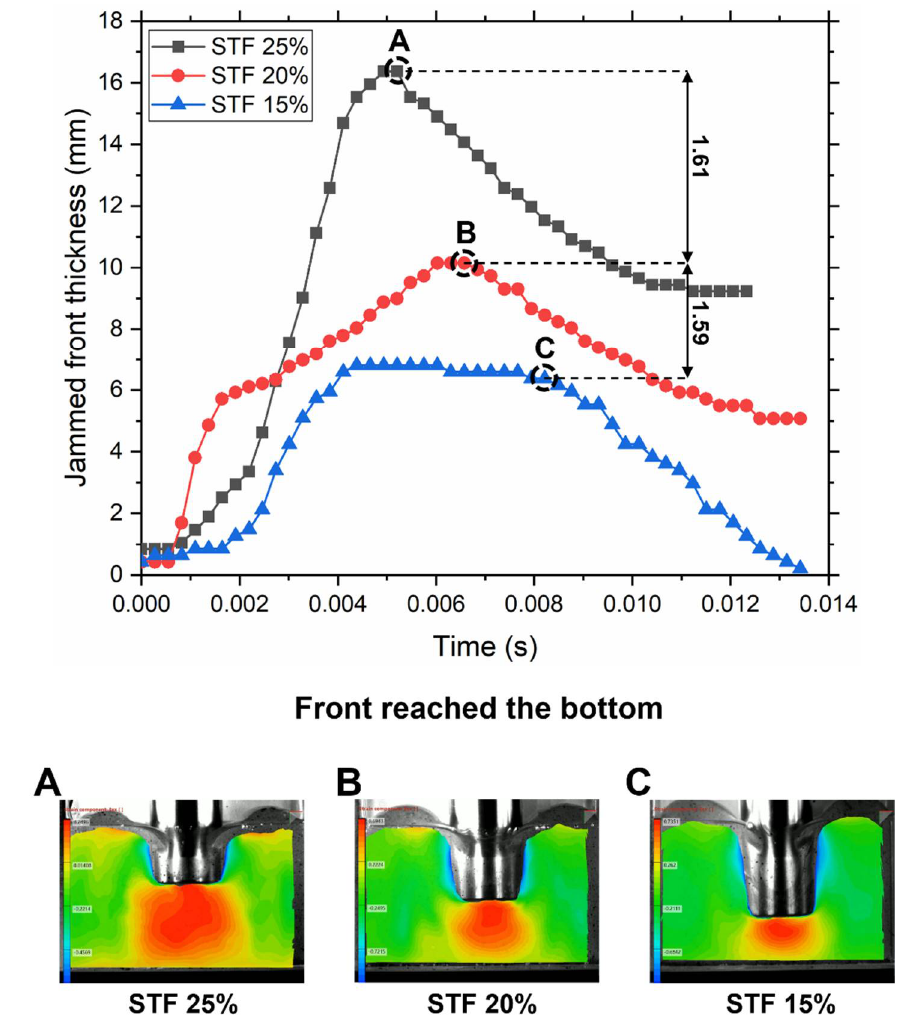
Figure 7. Jamming front propagation during impact. Calculated jamming front thickness during the impact of STF for three particles weight fractions. Front thickness was obtained measuring the maximum thickness of the third strain isoline (dark orange) in a vertical direction from the rod bottom surface. ( A - C ) Color-graded strain fields were calculated using DIC software. Red represents the highest displacement value, where yellow is the lowest and the green color represents no displacement. The red zone is the jamming front propagating towards the bottom at a speed faster than the speed of the rod. Captured pictures are front dimensions at the moment of reaching the bottom.